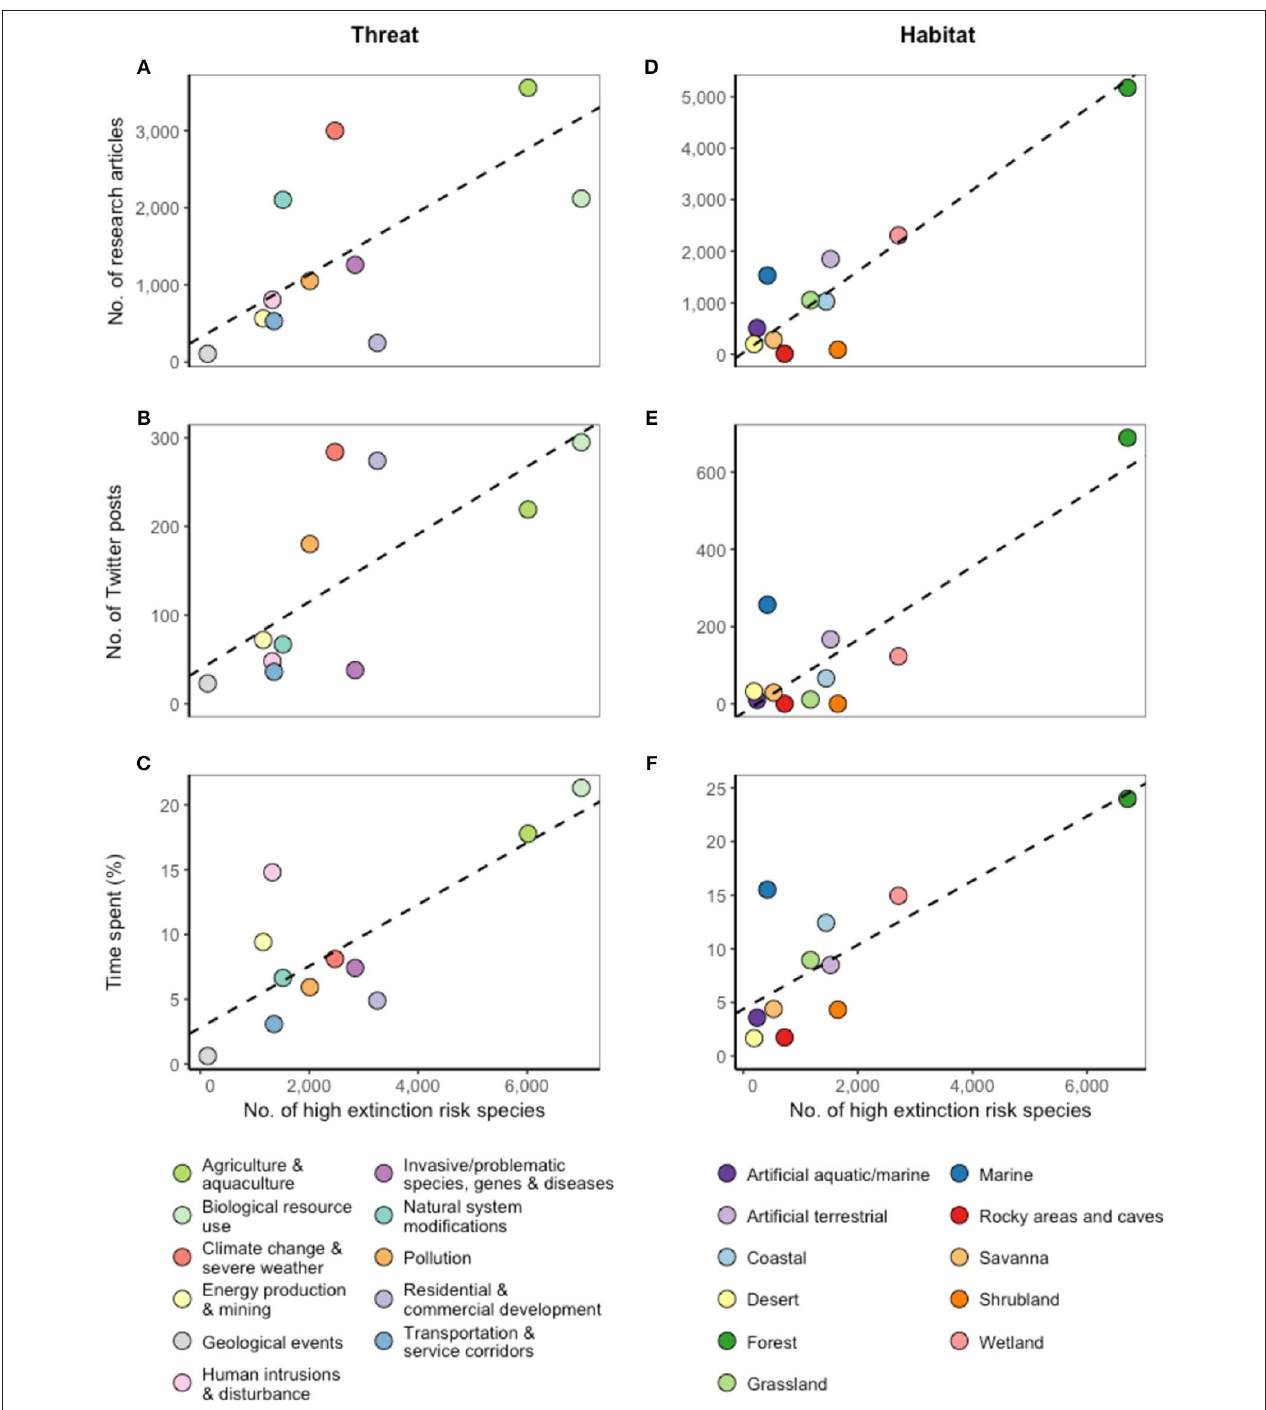
FIGURE 5 | Conservation effort relative to the number of high extinction risk species across Red List Threats and Habitats. Research data covers 5 years 01/01/2013–31/12/2017, Twitter data 150 consecutive days 31/12/2017–29/05/2018, and time data one year 01/08/2017 – 31/07/2018. Black dotted lines are major axis models (for A–F : r 2 = 0.40, 0.52, 0.62, 0.84, 0.74, 0.63 respectively; all p < 0.05). Points above the line receive above average effort per species, points below the line receive below average effort per species.